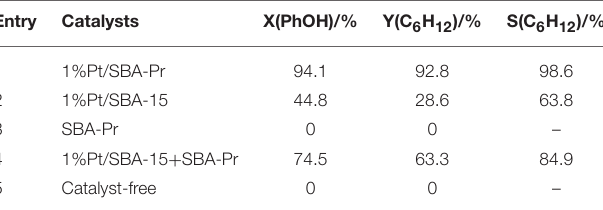
TABLE 2 | Catalytic performance for HDO of phenol.